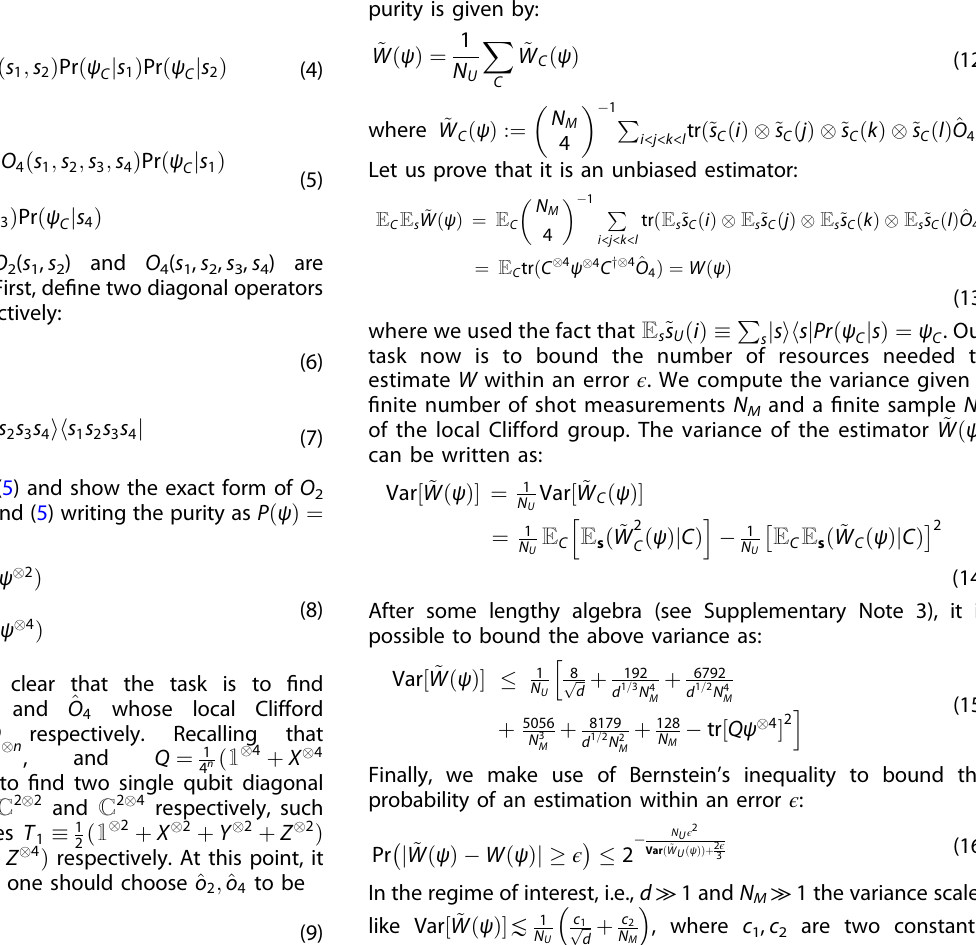
~ Pur ð ψ Þ(cid:6) ¼ Oð dN (cid:2) 1